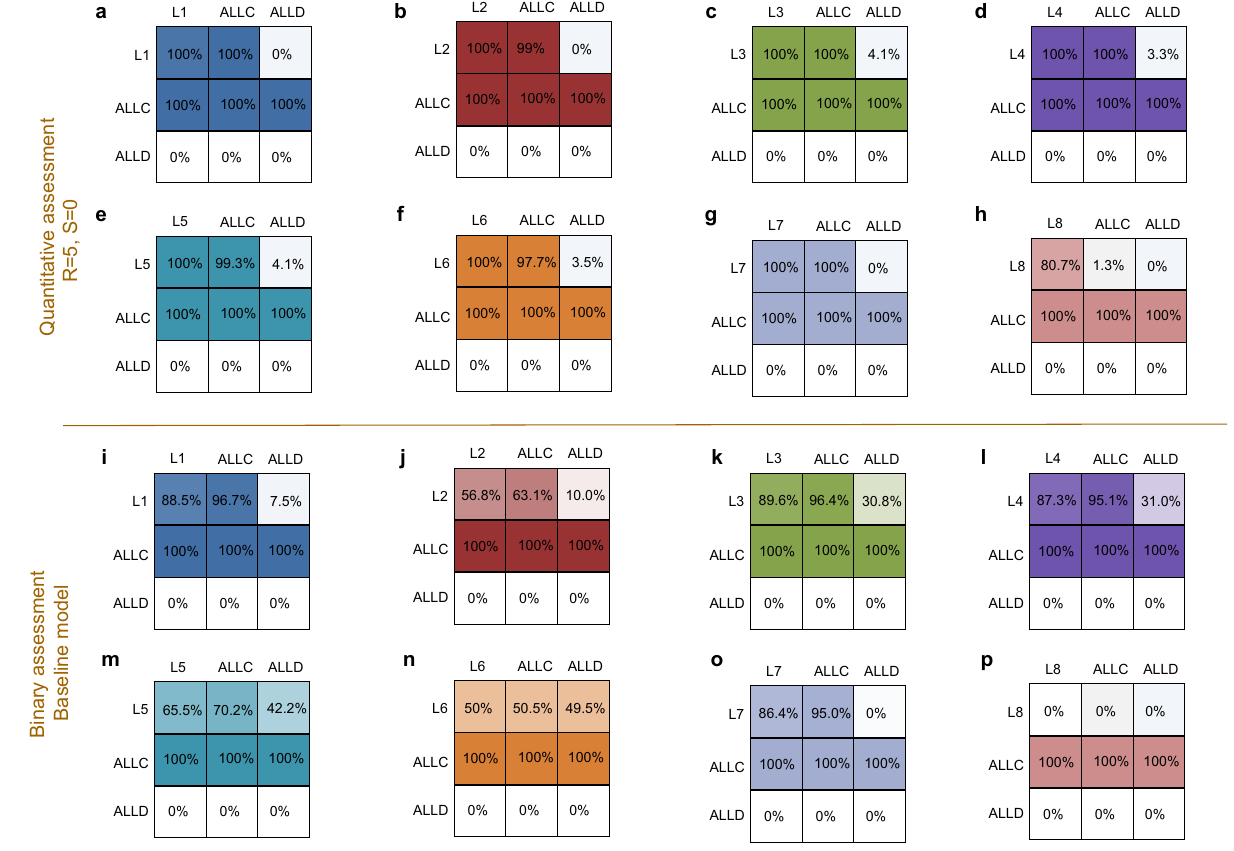
accuracy with which players assign each other images. All leading eight norms achieve a perfectly correlated good self-image, as opposed to the baseline model, where only L 1 ( i ) and L 7 ( o ) achieve a self-image of more than 80% good. Players usingquantitativeassessmentalsodomuchbetterinjudging ALLD asbad,andwith the exception of the (less stable) L 8 ( h , p ), also manage to assess ALLC as close to 100% good. This hints at the power of a more re fi ned reputation dynamics. The parameters are the same as in Fig.